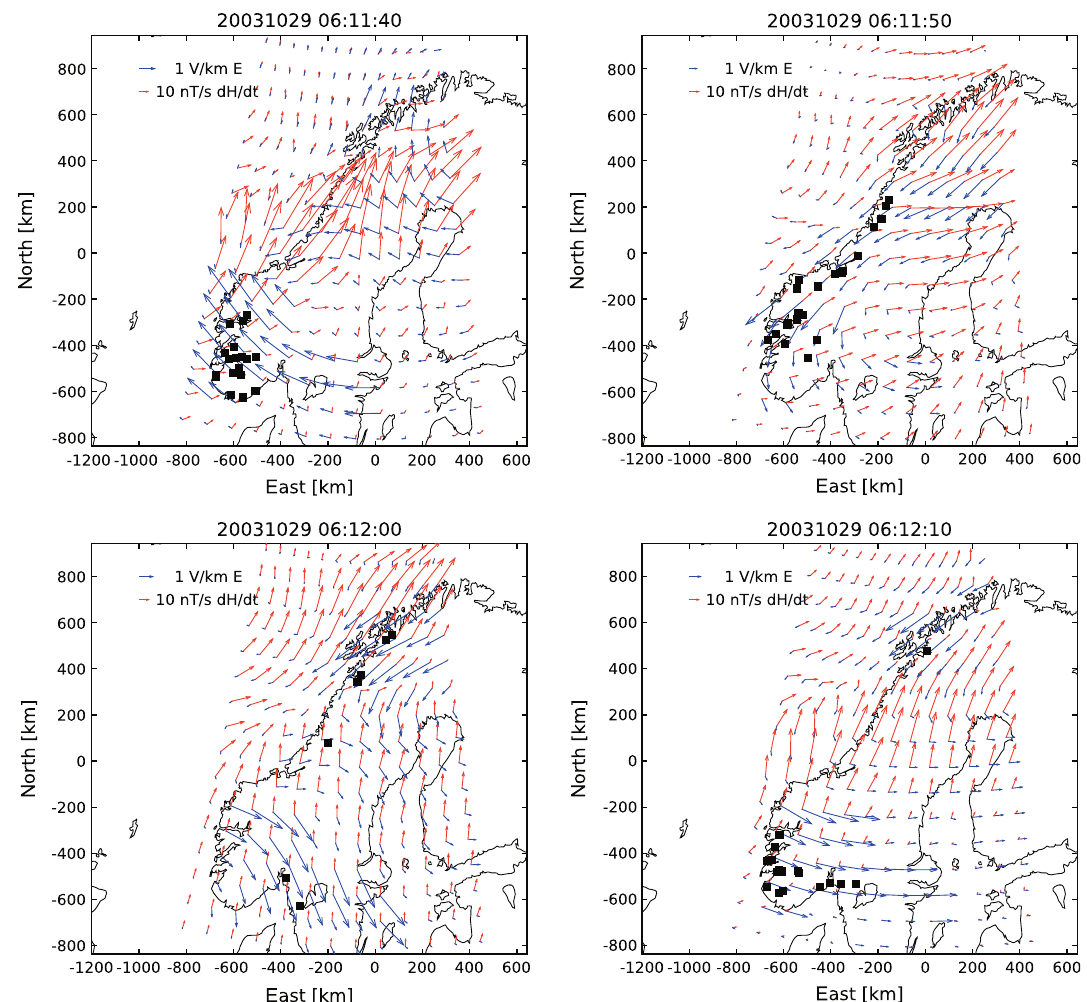
Fig. 9. Beginning of the magnetic storm on 29 October 2003 at 06:11:40–06:12:10 UT. Red arrows: time derivative of the horizontal magnetic field, blue arrows: electric field. Black small dots indicate the transformers stations at which the daily maximum GIC occurred at the given time step.